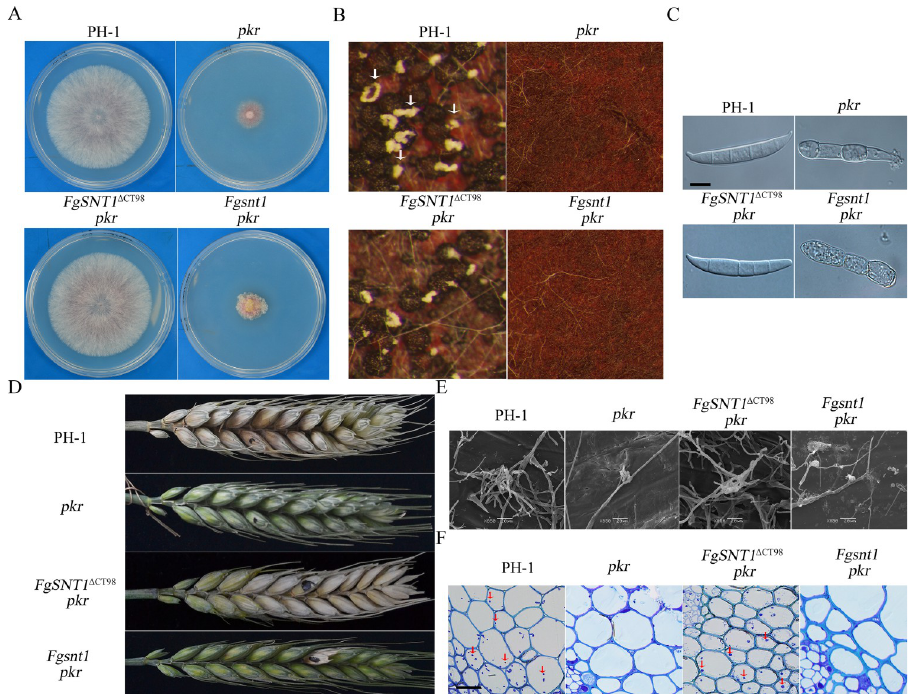
Fig 2. Deletion of the C-terminal region of FgSnt1 partially rescues the defects of pkr . (A). Three-day-old PDA cultures of the wild-type strain PH-1 and the pkr , FgSNT1 Δ CT98 pkr and Fgsnt1 pkr mutants. (B). Perithecia from mating cultures of the same set of strains were examined at 12 days post-fertilization (dpf). Arrows point to ascospore cirrhi oozed out from black perithecia (C). Conidia of the same set of strains from 5-day-old CMC culture. Bar = 10 μ m. (D). Wheat heads inoculated with the marked strains were examined for head blight symptoms at 14 days post-inoculation (dpi). Black dots mark the inoculated spikelets. (E). Infection cushions formed on wheat lemma were examined by SEM under × 850 at 2 dpi. Scale bars = 20 μ m. (F). Thick sections of wheat rachises inoculated with the marked strains were examined for invasive hyphae at 5 dpi.